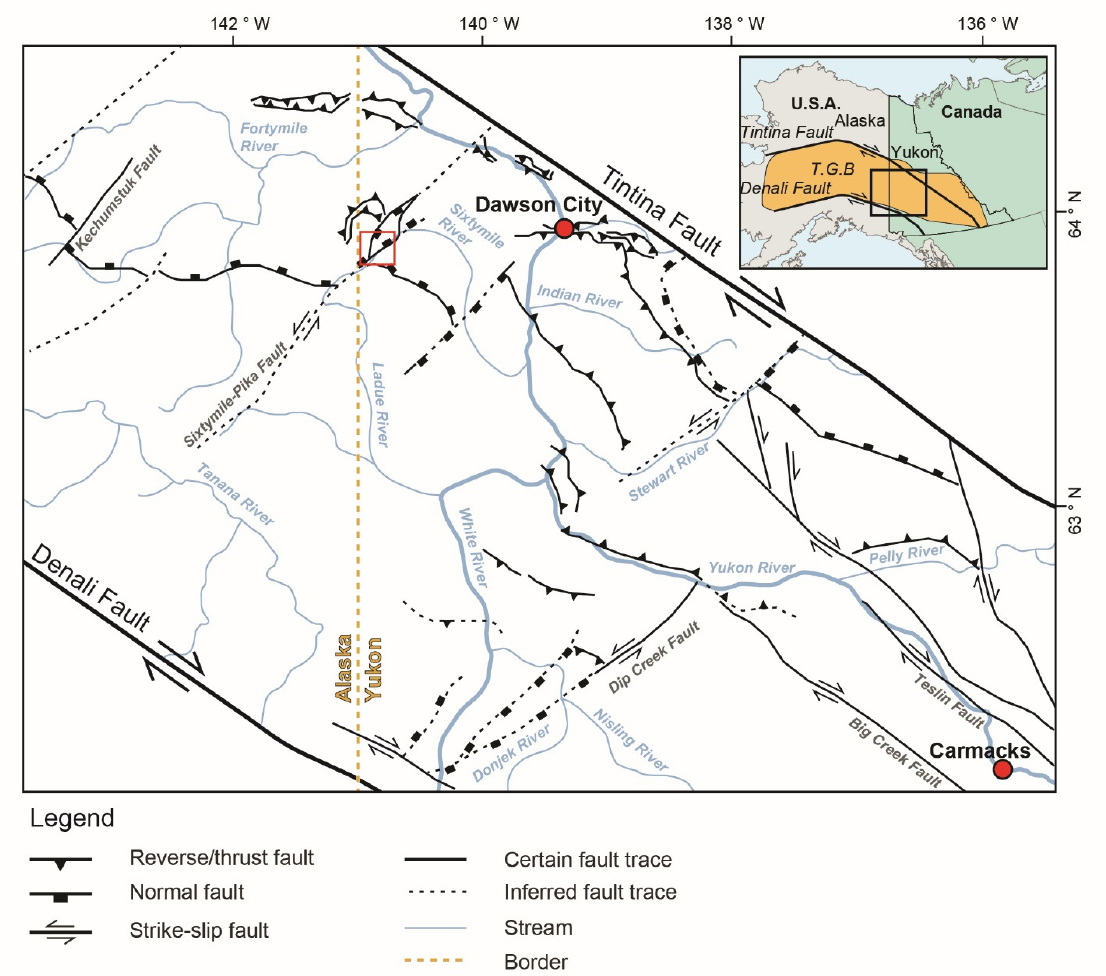
Figure 1. Regional structures in the Alaska-Yukon region (modified after Allan et al., 2013) [8]. Inset map shows the location of the Tintina Gold Belt (T.G.B.). The study area (red box) is located close to the Alaska–Yukon border and lies within an area interpreted as a pull-apart basin resulting from left stepover on the left-lateral Sixtymile-Pika Fault.